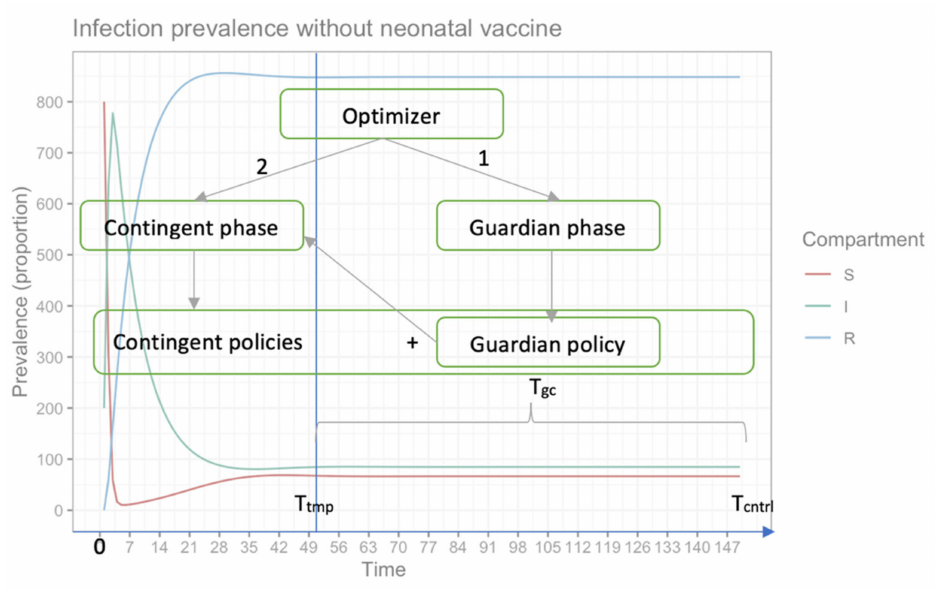
Figure 2. Anatomy of the optimizer’s main